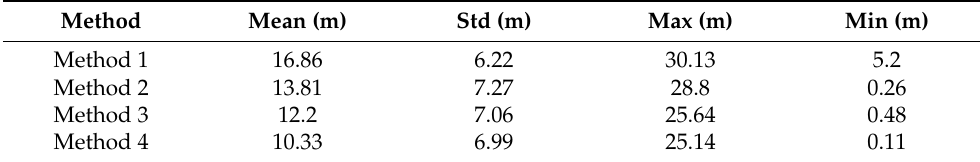
Figure 18. The error analysis of different methods. Table 3. Comparison of the position results of different